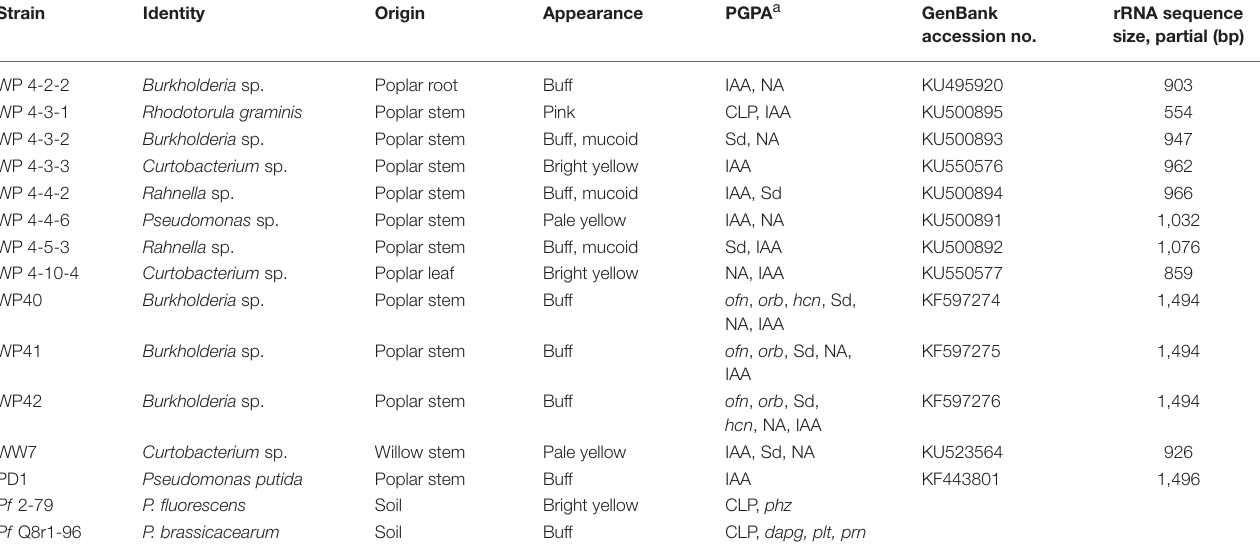
TABLE 1 | Endophyte strains used in this